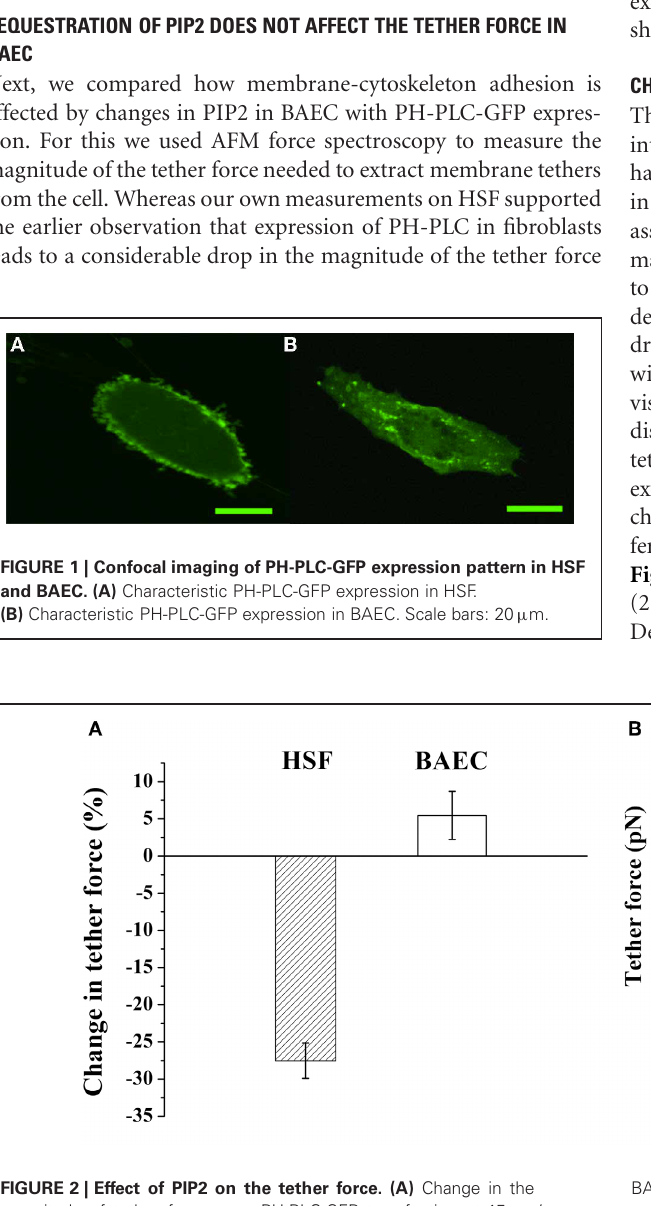
BAEC transfected with PH-PLC-GFP. Cells treated with GFP alone were used as control. The two curves are statistically indistinguishable ( p > 0 . 05). (The slope of two curves, 2 πη eff , is 1.60 pN · s/ μ m and 1.67 pN · s/ μ m, respectively, for the GFP treated cells and cells transfected with PH-PLC-GFP). Error bars represent